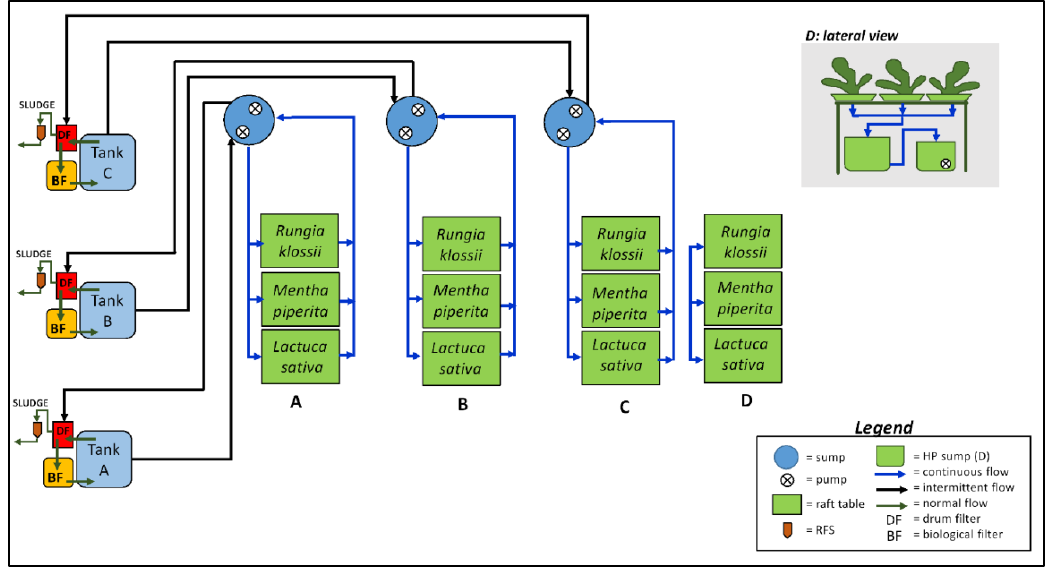
Figure 7. Illustration of the aquaponic (A, B, C) and hydroponic (D) experimental units with water flows.